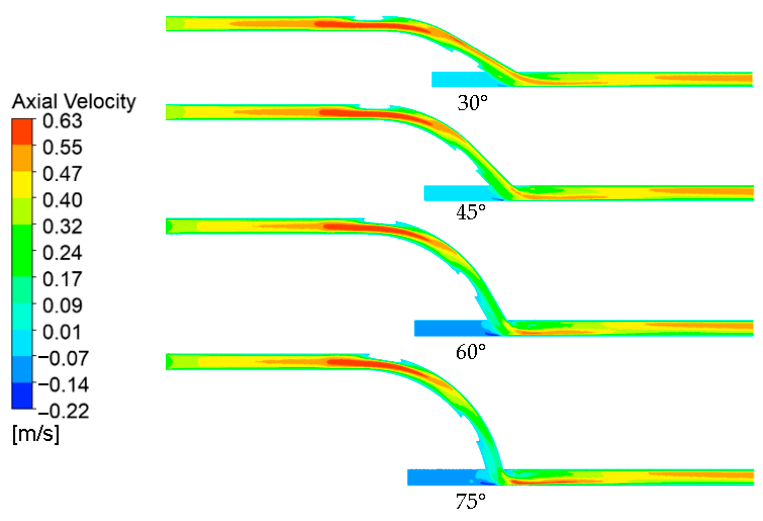
Figure 6. Axial velocity contours across the longitudinal section of the models.